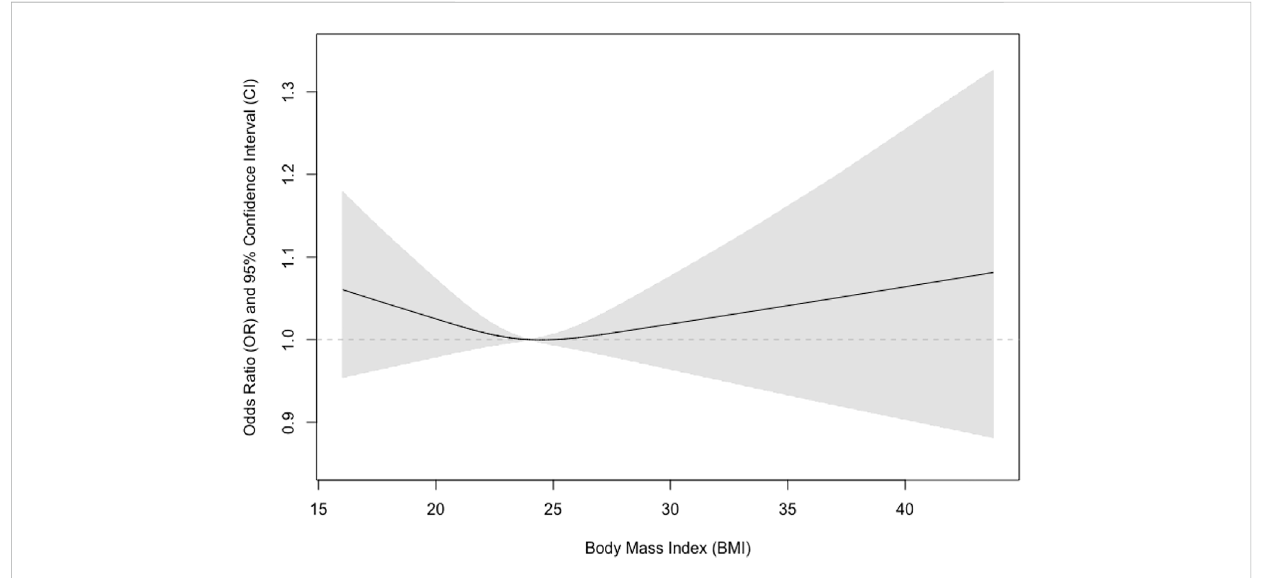
FIGURE 6 Association between body mass index and COPD in